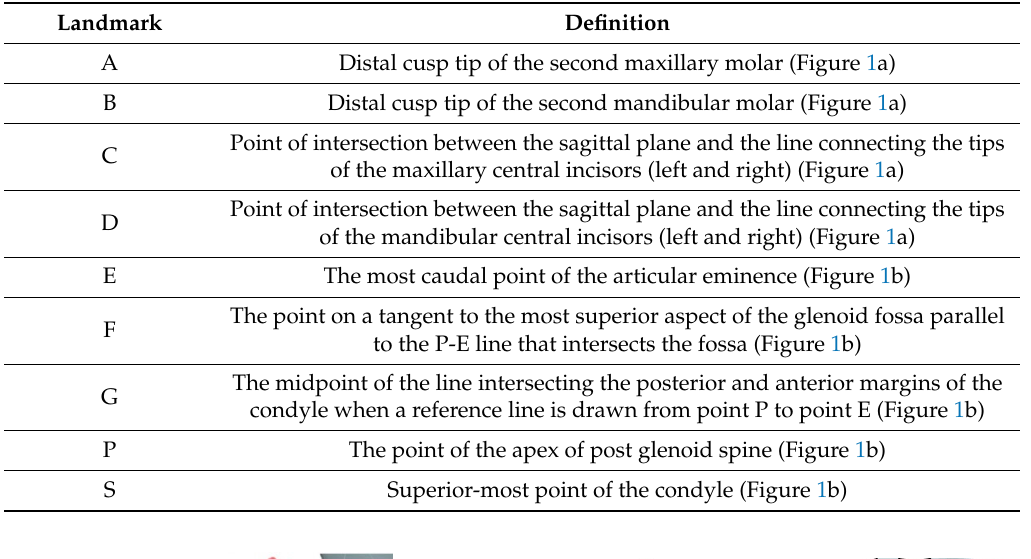
Table 1. Landmarks used in this study.